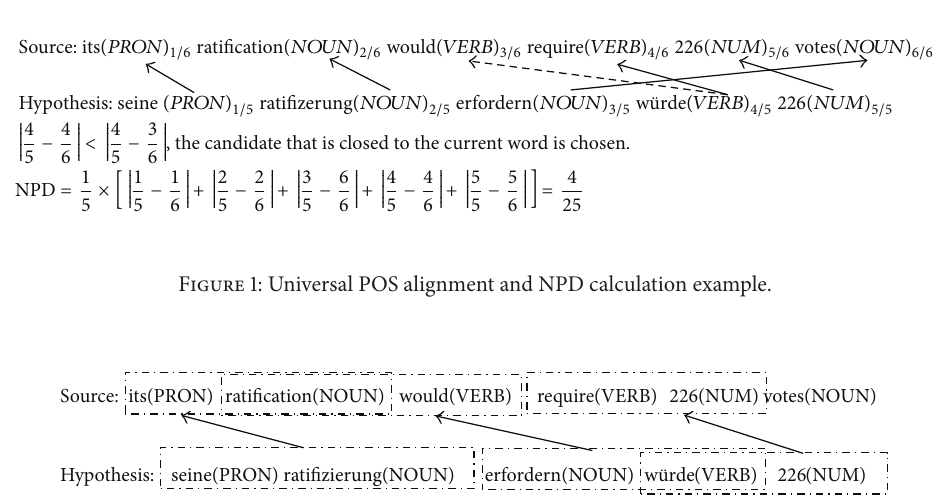
Figure 2: Universal POS chunk matching example for bigram precision and